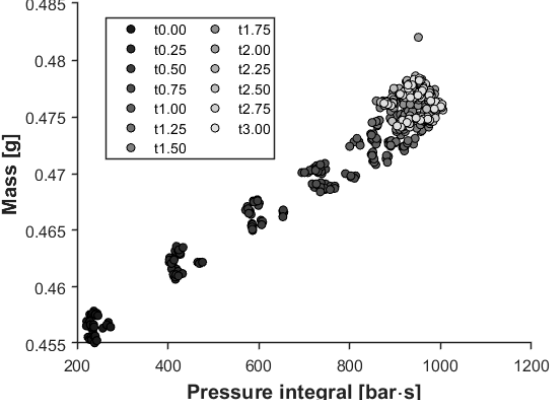
Figure 13. Relationship between the pressure integral and sample mass (R = 0.973 with a significance level of 0.05).